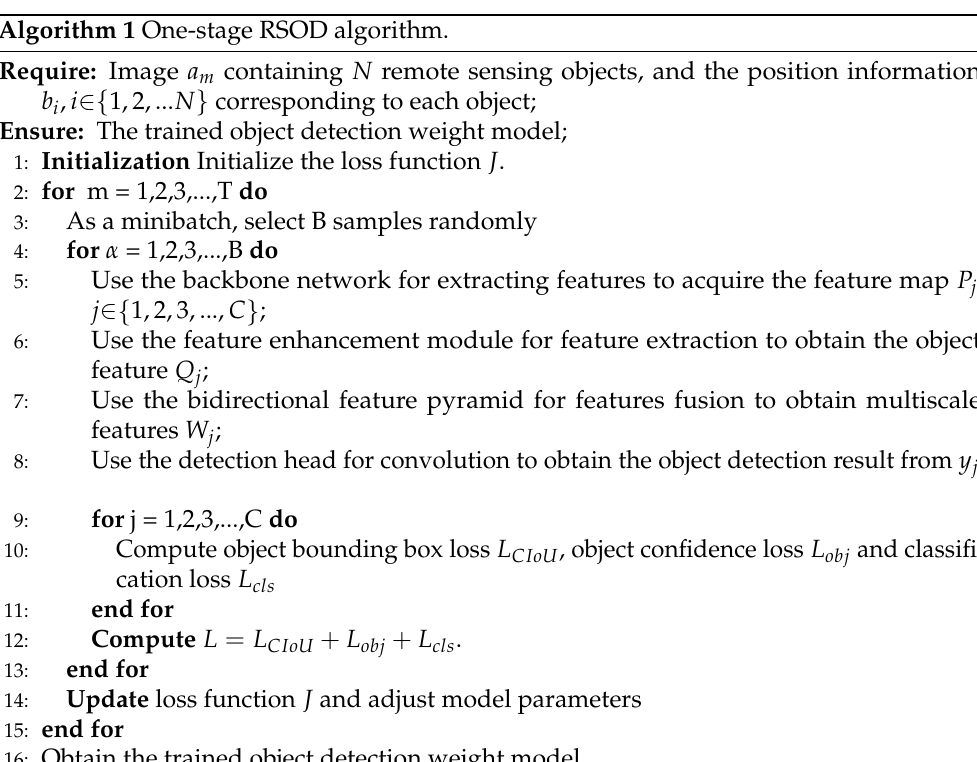
Algorithm 1 One-stage RSOD